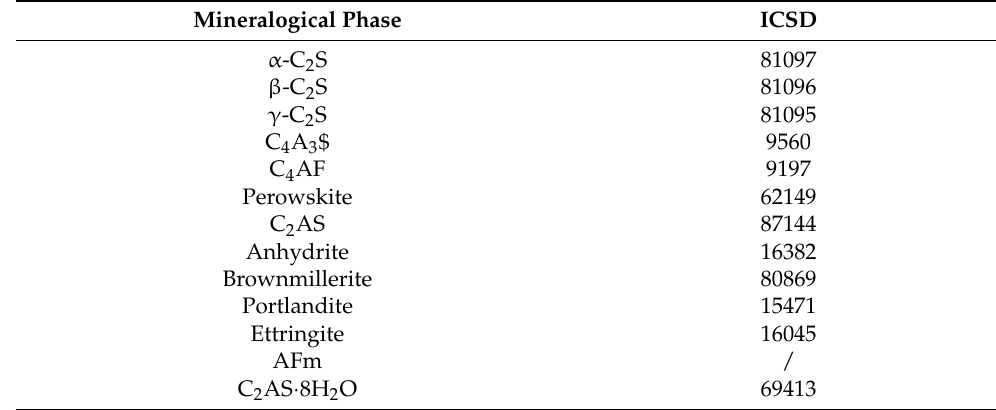
Table 3. The ICSD of the main minerals in the BBSC clinkers and their hydration products in this